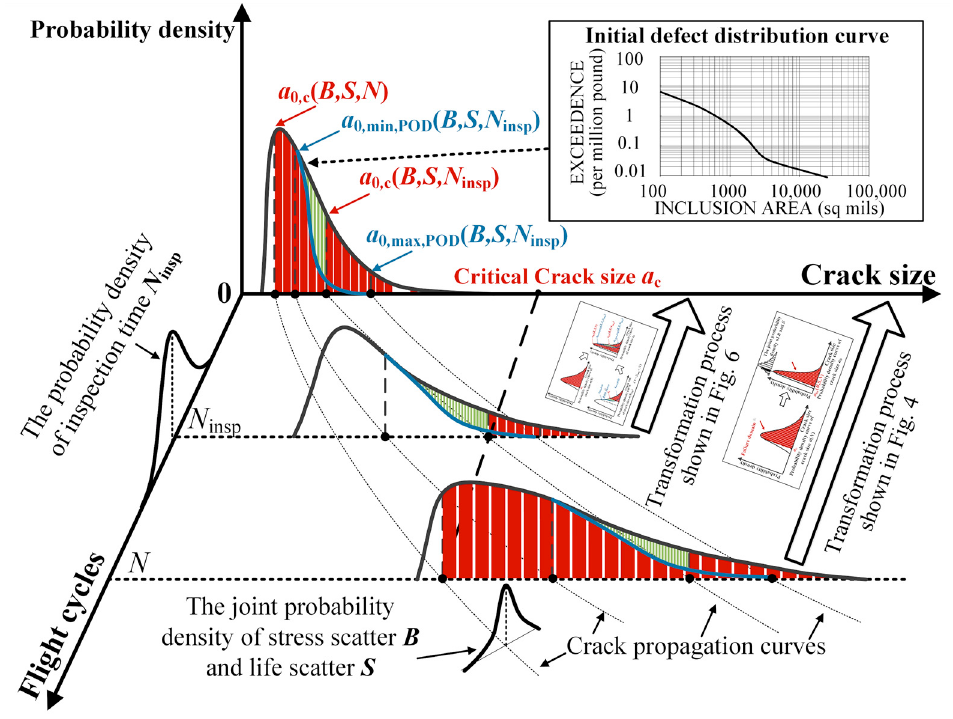
Figure 8. Schematic diagram of failure probability risk evolution process with in ‐ service inspection.